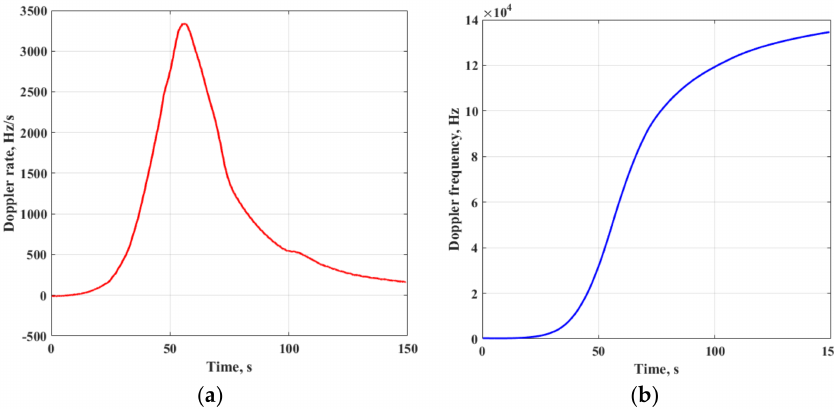
Figure 24. Estimation result of an IFR tracking approach for one aerobraking flight trial at CNR = 22.6 dB-Hz: ( a ) Doppler rate; ( b ) Doppler frequency.